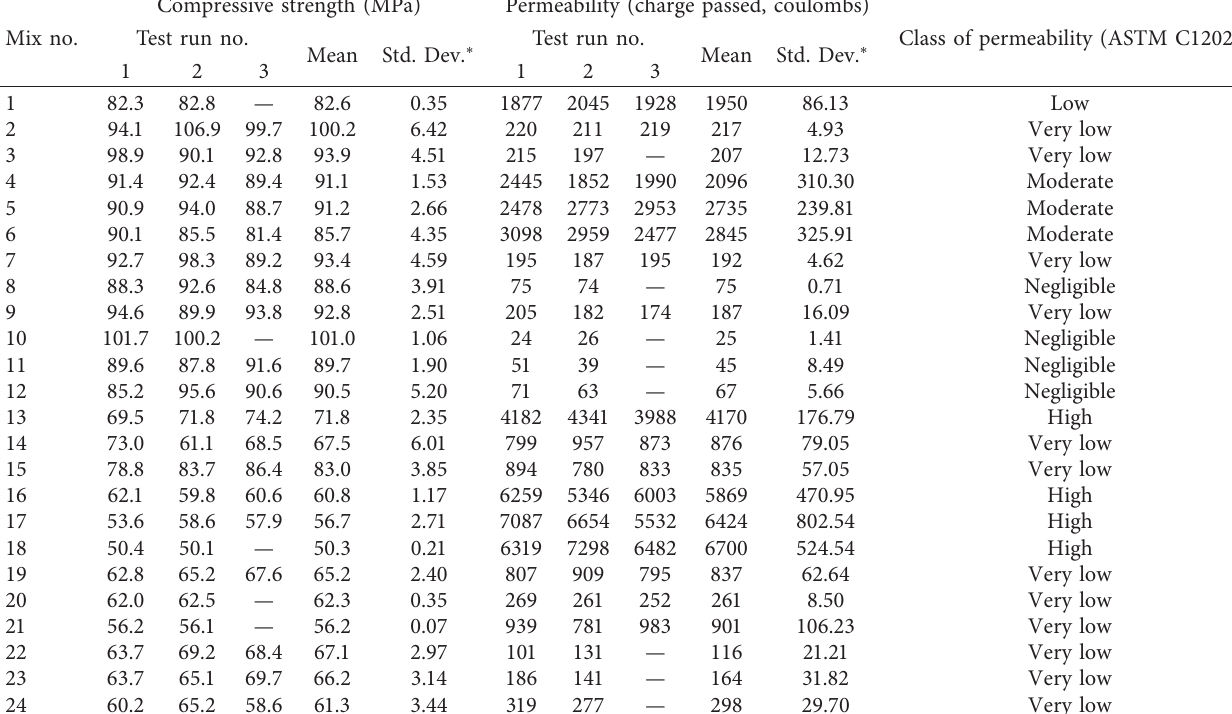
Table 4: Summary of the experimental results of concrete mixtures.